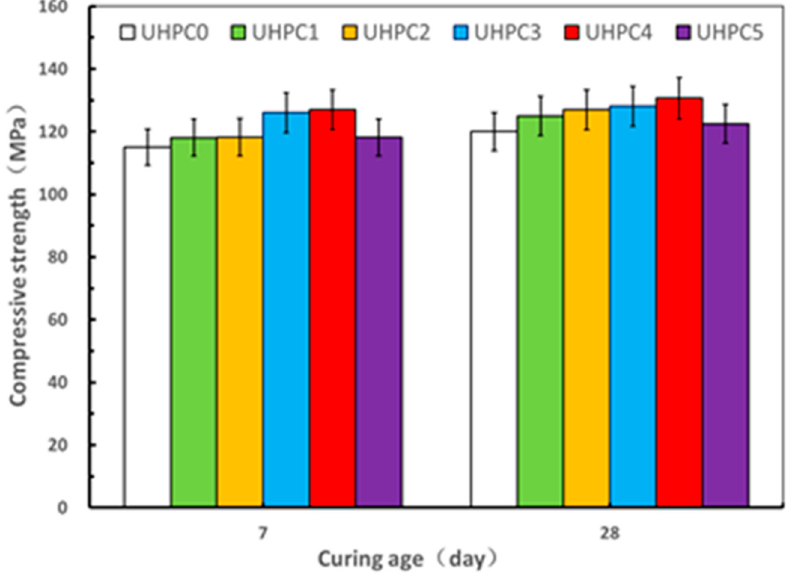
ff ect of GO nanosheets on compressive strength under steam Figure 7. Effect of GO nanosheets on compressive strength under steam curing. Figure 7. E